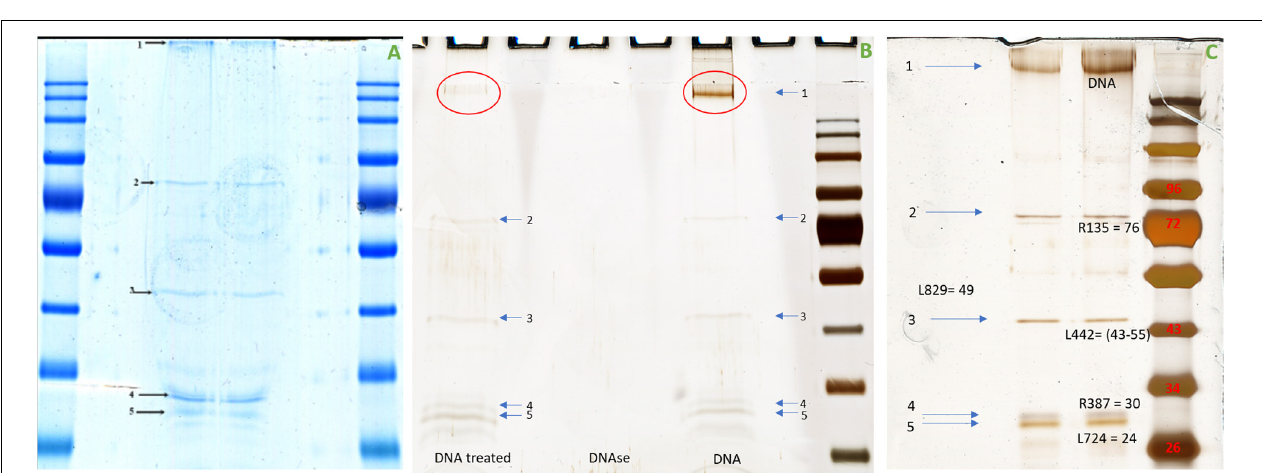
FIGURE 4 | Gating and microscopic control. (A) Flow cytometry dot plot showing the single viral profile in SSC (side scatter) versus FITC (SYBR green DNA contents) of mimivirus. (B) Scanning electron microscopy with Hitachi TM4000 of a culture supernatant showing mimivirus particles.